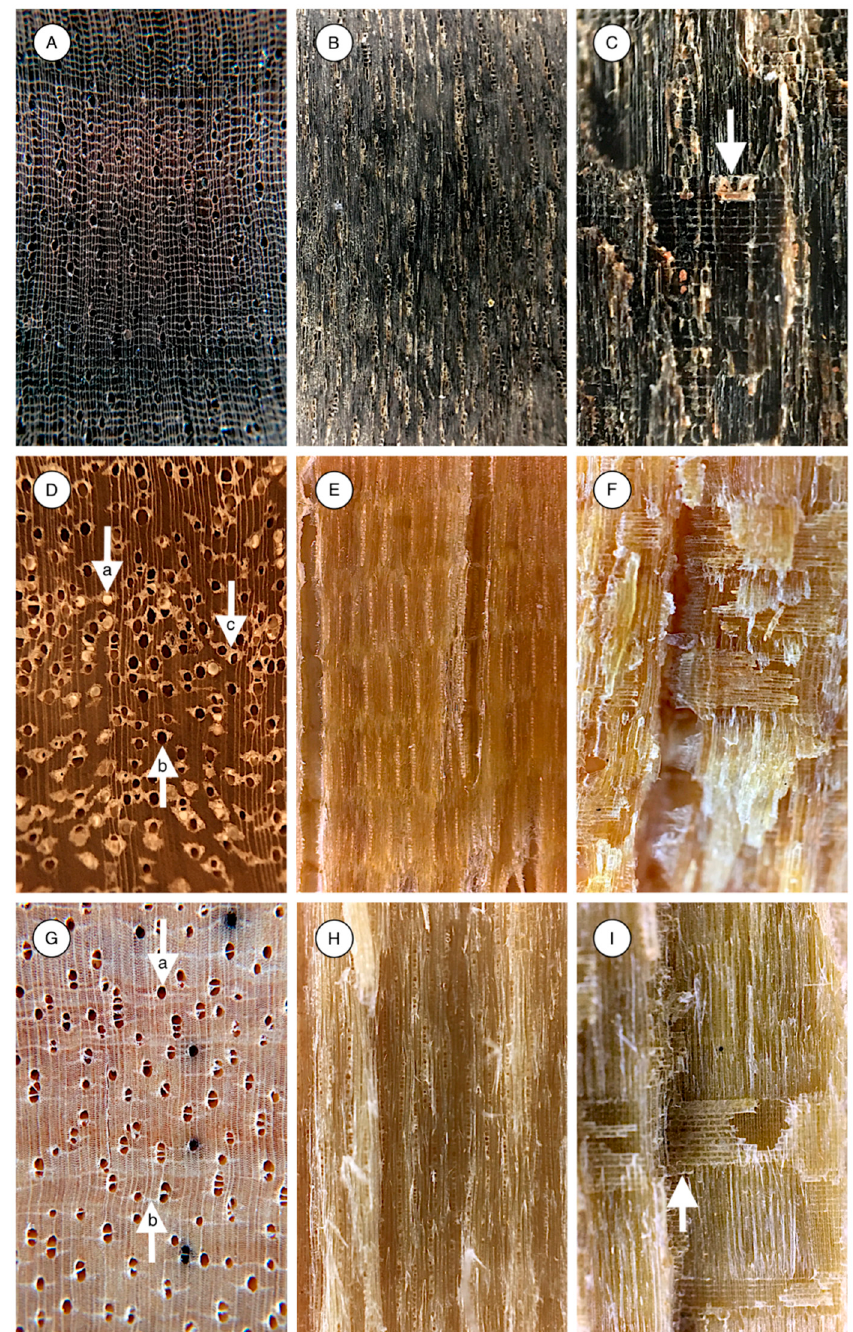
Figure 8. Elements visible with 400× lens in hardwoods. Diospyros spp. ( A ) Axial parenchyma in marginal or in seemingly marginal bands and diffuse-in-aggregates forming a reticulate pattern with rays. ( B ) Non-storied rays. ( C ) Procumbent body ray cells with one row of upright and/or square marginal cells. Dipteryx panamensis (Pittier) Record and Mell. ( D ) ( a ) White deposits in vessels; ( b ) lozenge-aliform axial parenchyma; ( c ) confluent axial parenchyma. ( E ) Rays 1 to 3 cells wide, storied. ( F ) Homocellular rays with procumbent cells. Gonystylus spp. ( G ) ( a ) Winged-aliform axial parenchyma; ( b ) confluent axial parenchyma. ( H ) Uniseriate rays, non-storied. ( I ) Procumbent body ray cells with one row of upright and/or square marginal cells.